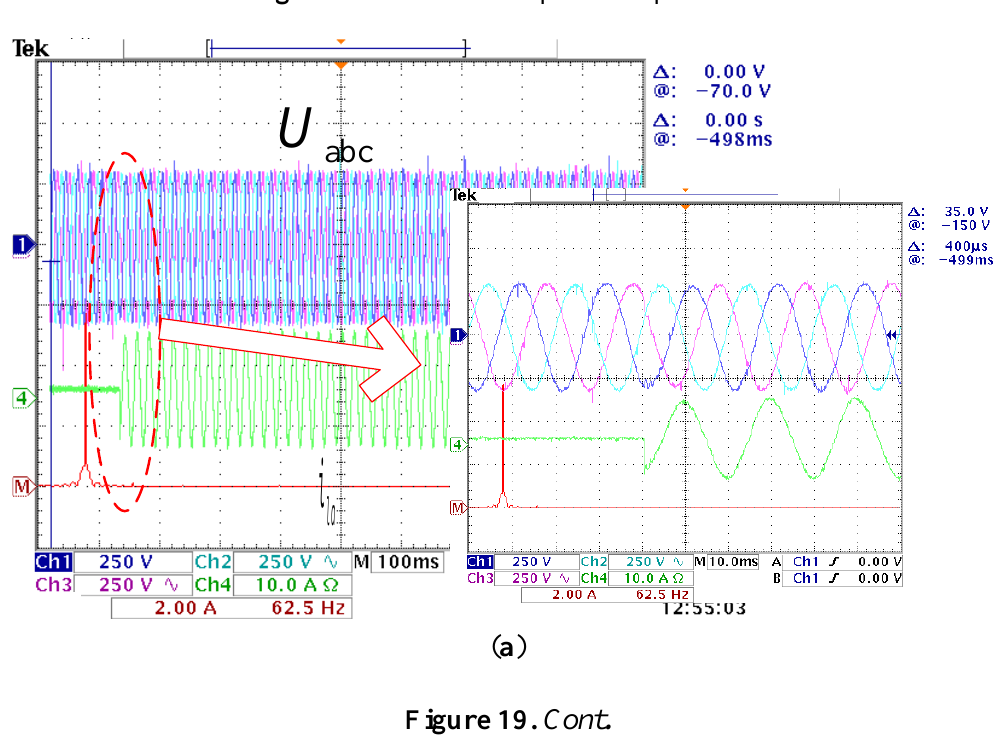
Figure 18. Hardware experiment platform.